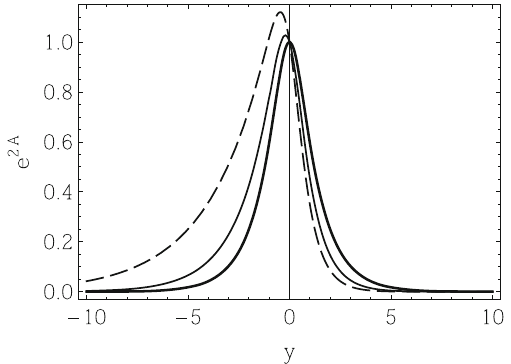
Fig. 14 Plot of ψ( y ) for ψ 0 = − 1, λ = 0 (thick-solid line), λ = 0 . 3 (thin-solid line), λ = 0 . 6 (dashed line) and λ = 0 . 9 (dot-dashed line)